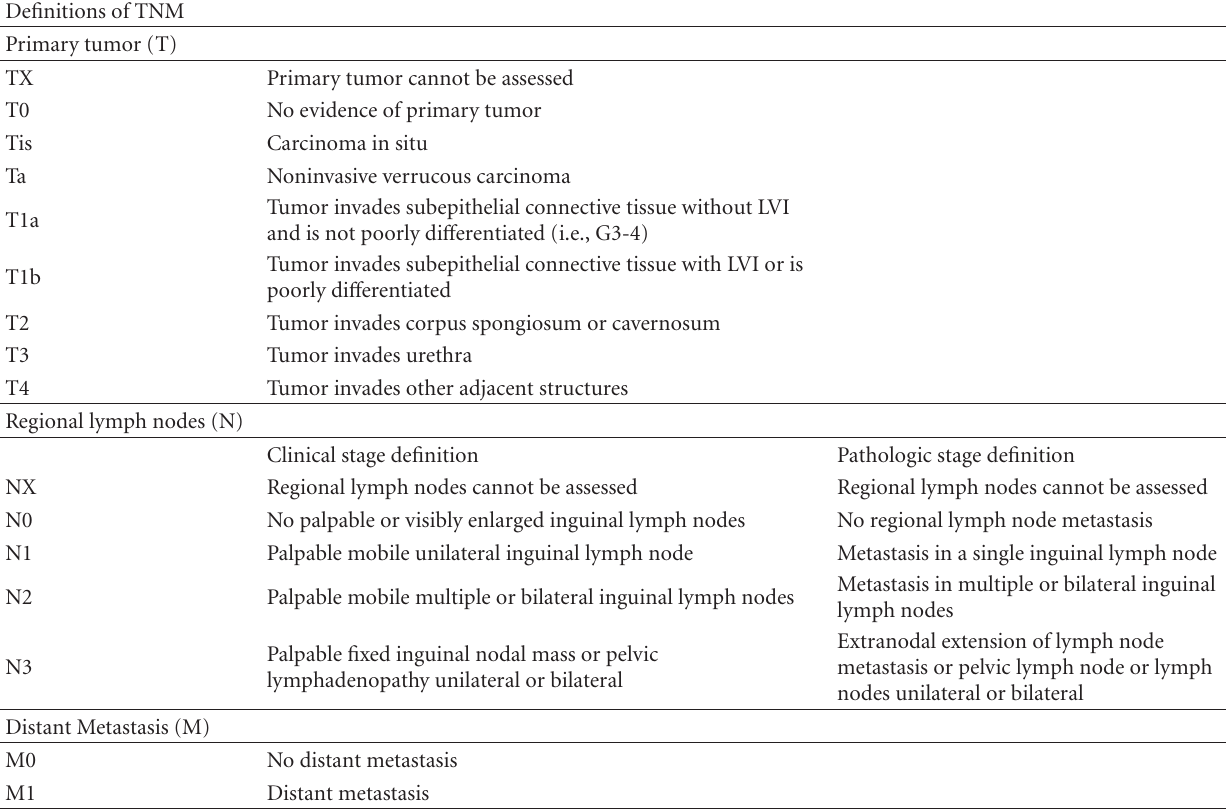
Table 1: TNM staging system for penile